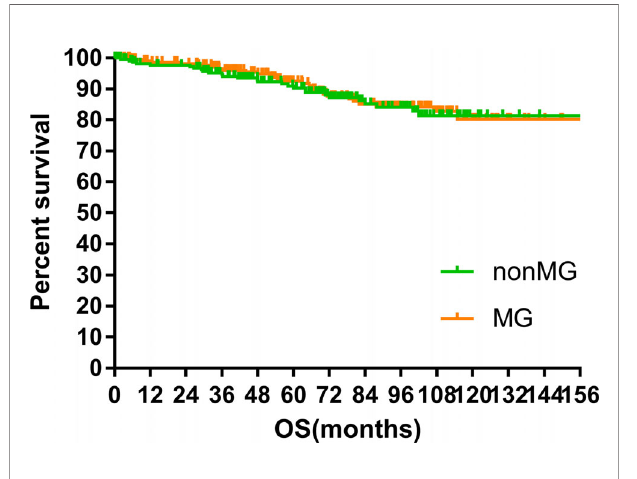
FIGURE 4 | Distant metastasis free survival.